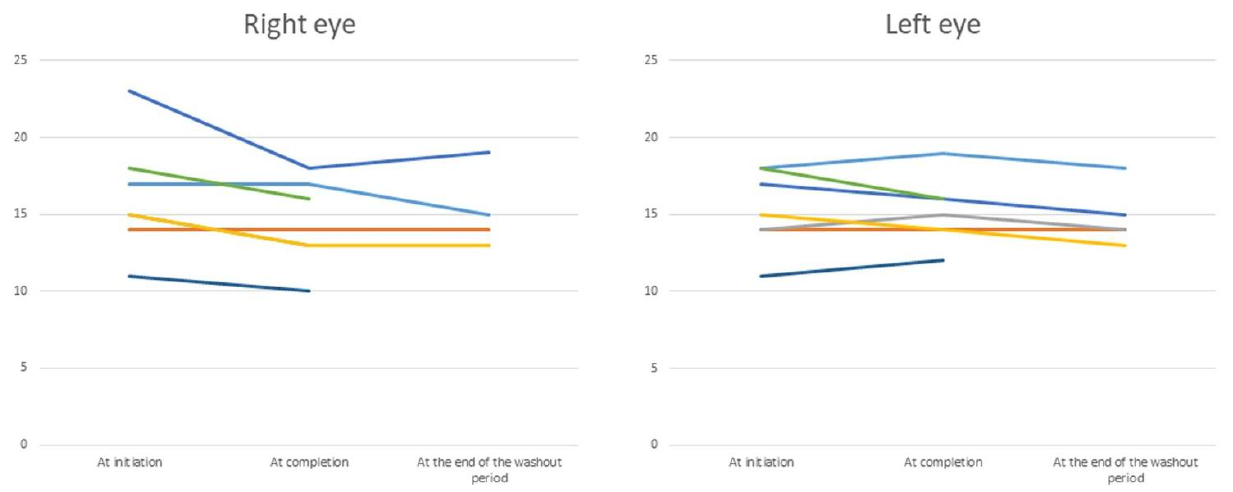
Figure 3 : Intraocular pressure. No increase of the intraocular pressure was observed (including the 2 patients who discontinued treatment due to adverse